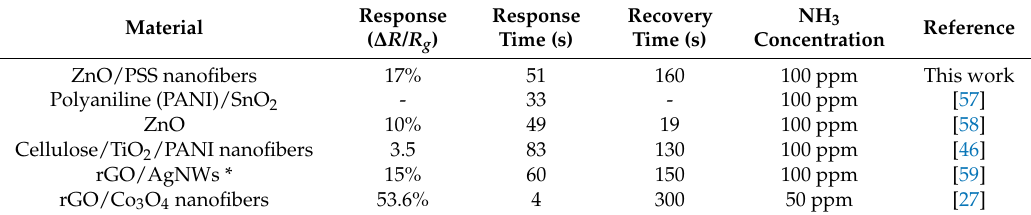
Table 1. NH 3 sensing properties of reported sensors based on hybrid materials.